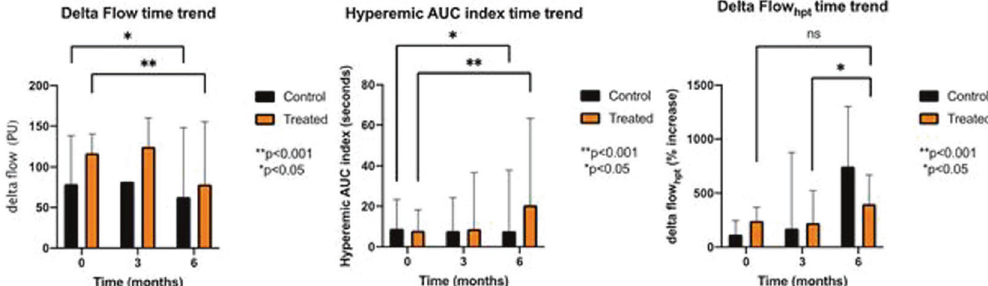
Fig. 1 Time trend variation of Peri fl ux data. Difference in the fl ow time trend between baseline, time-3-months, and time-6-months both in the placebo group and in the treatment group. * p < 0.05. ** p < 0.001. ns not signi fi cant, PU perfusion unit, AUC area under the curve, HPT heat provocation test.